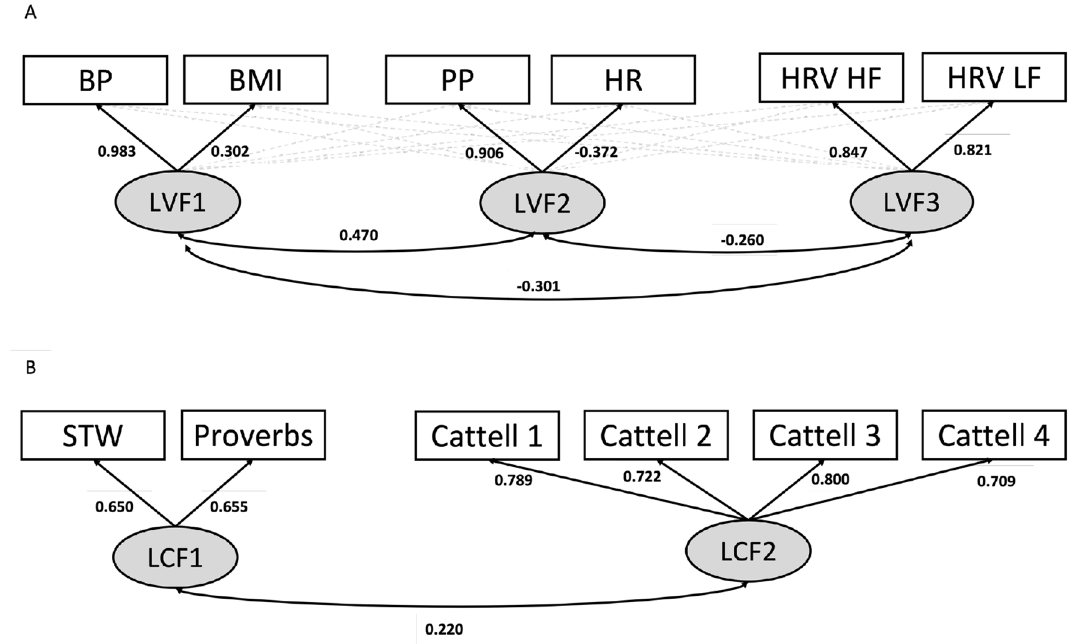
Figure 2. A The three-factor Exploratory Factor Analysis model of vascular health. The numeric values of cross-loadings < 0.30 (dashed grey arrows) are omitted here for visual clarity and reported fully in Supplementary Table 5. B The two-factor Confirmatory Factor Analysis model of cognition. BMI body mass index, BP total blood pressure, HR heart rate, HRV HF heart rate variability at high frequency, HRV LF